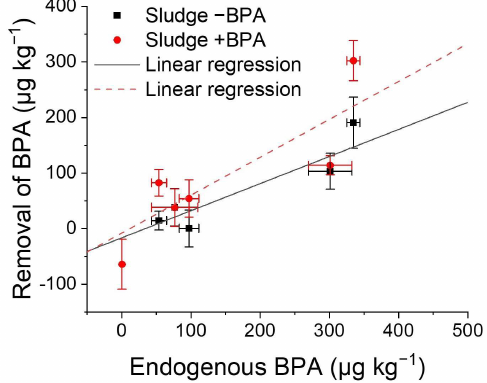
Figure 6. Correlation of removal of bisphenol A with endogenous BPA concentration. Spiked sludges (+BPA) received 228 µg kg −1 of BPA, and untreated samples (−BPA) were used without additional BPA. Absolute removal and endogenous BPA concentration were calculated for six aqueous sludges (−BPA: Pearson correlation coefficient r = 0.921, n = 5, p < 0.05; +BPA: r = 0.858, n = 6, p < 0.05). Standard deviations of triplicates are represented by error bars. Linear regressions were calculated with x and y errors according to York et al. (2004) [52].